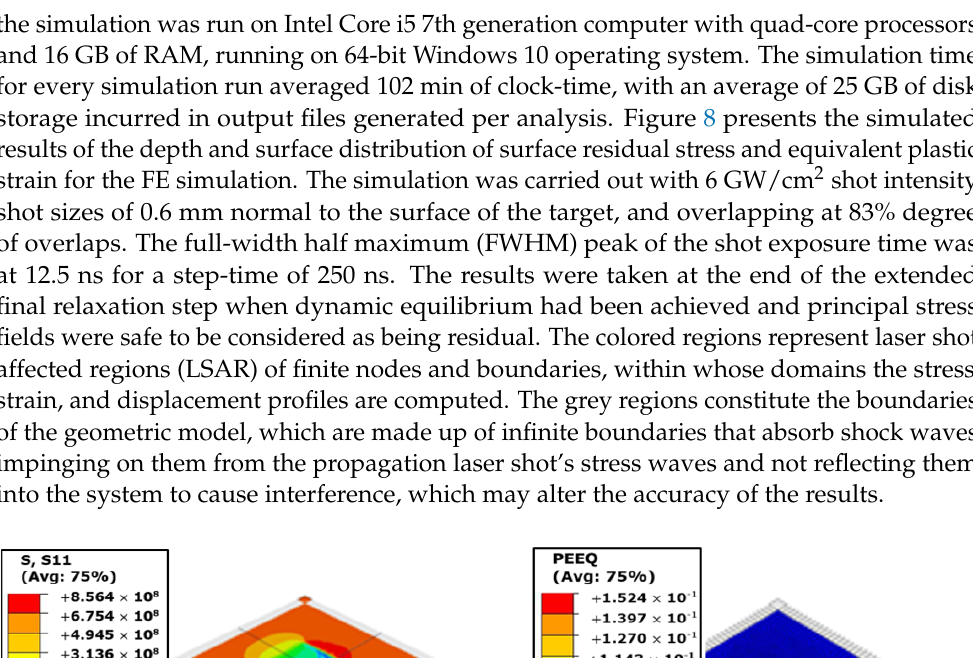
Figure 7. System dynamic response and energy field profile.